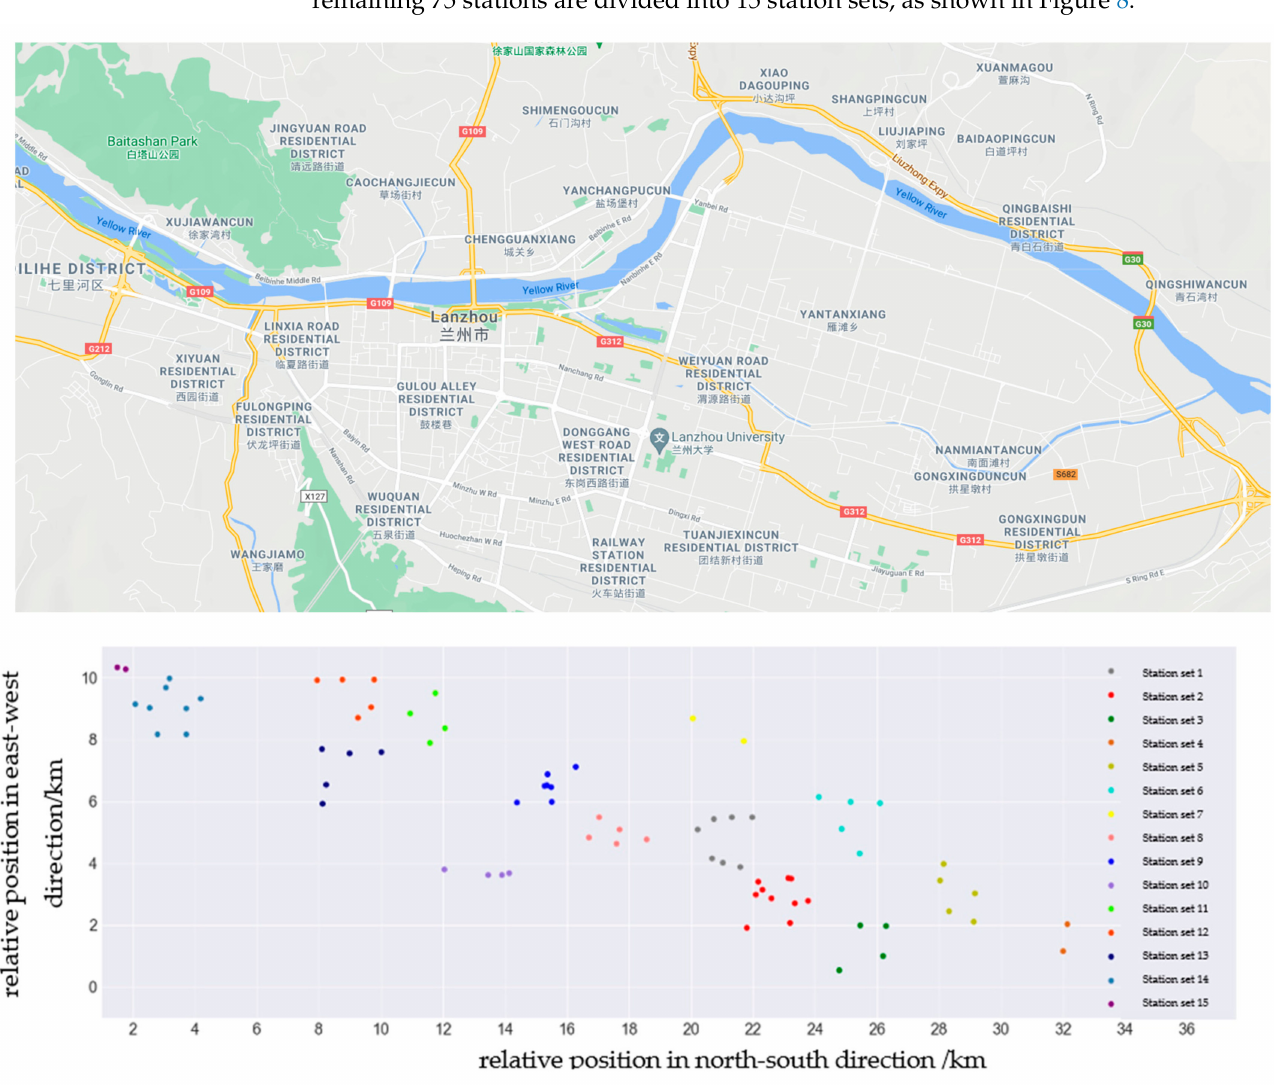
Figure 8. Results of station